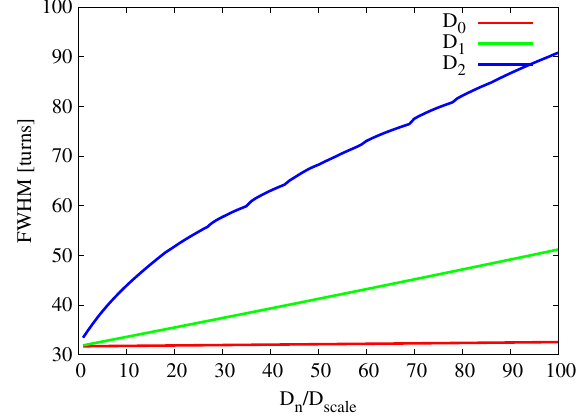
FIG. 2. FWHM as a function of the diffusion coefficients D 0 , D D D . Each curve shows the 1 , and 2 scaled by the value scale impact of the single coefficient with the others set to zero. The FWHM is calculated analytically from Eq. (24) for D 0 and D 1 and numerically for D 2 . Parameters were taken from Table I, except for μ ¼ 0 . 0077 .